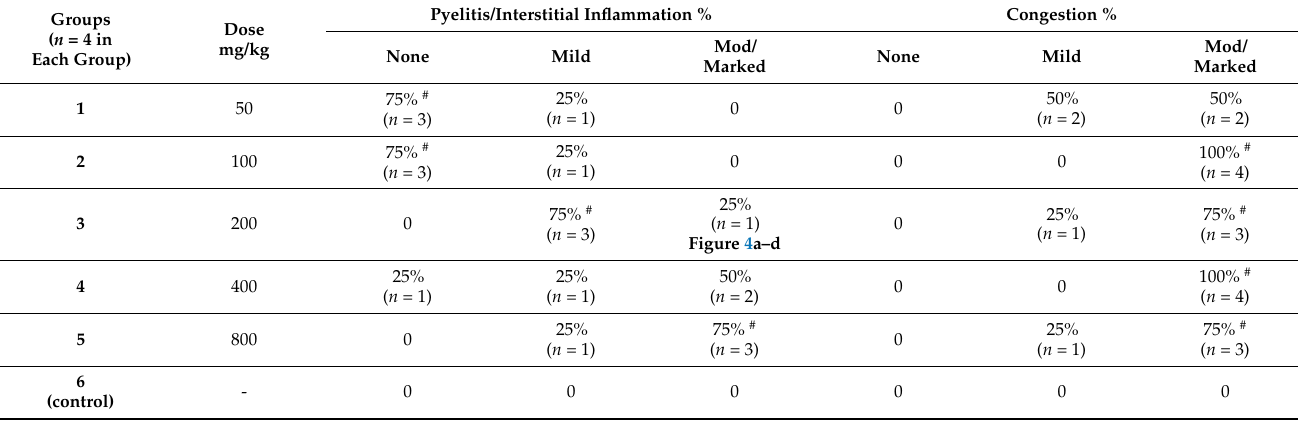
Table 4. Pyelitis/interstitial inflammation and congestion in renal tissue in acute toxicity study ( n = 24). Groups ( n = 4 in Each Group)